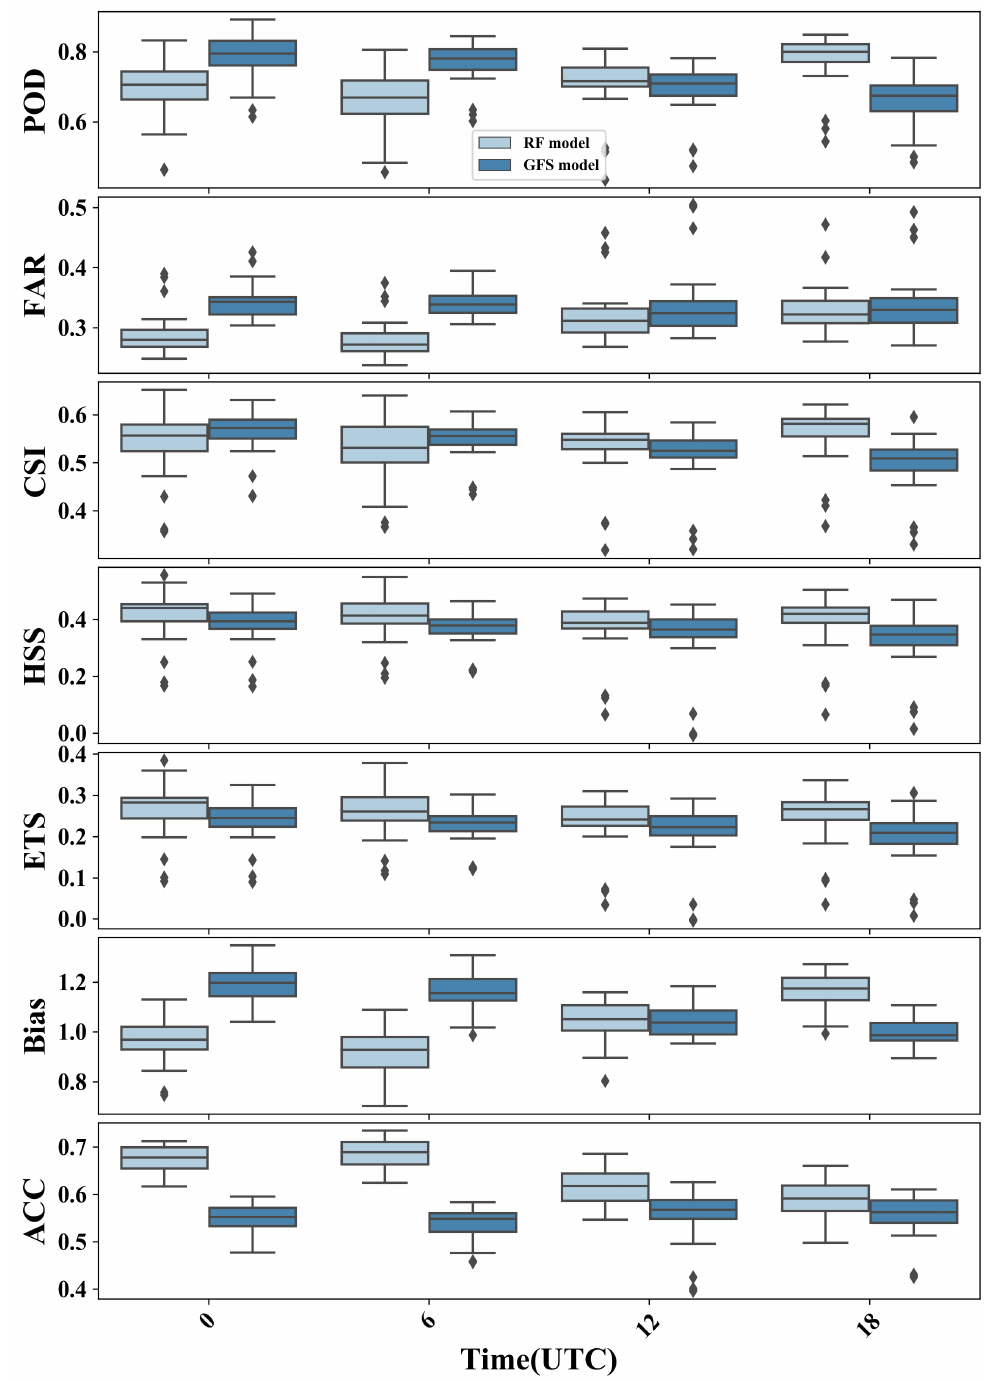
Figure 21. The diurnal variation of evaluation scores for rain area determination and precipitation grades estimation on RF model and GFS model against GPM data during August 2018, distributions of statistical values at six hour intervals are interpreted in box plots. Box diagrams indicate the 25th, 50th, and 75th percentiles whereas the periphery of the box extends to 1.5 times of the quartile deviation (25th–75th percentile). Outliers are indicated by black